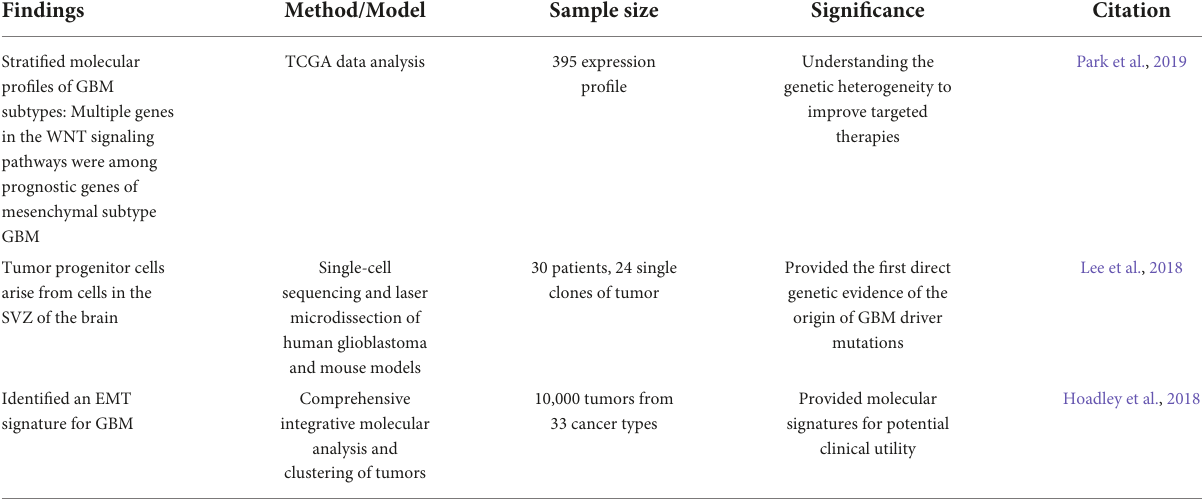
TABLE 2 Implication of WNT signaling in glioblastoma (GBM) development and